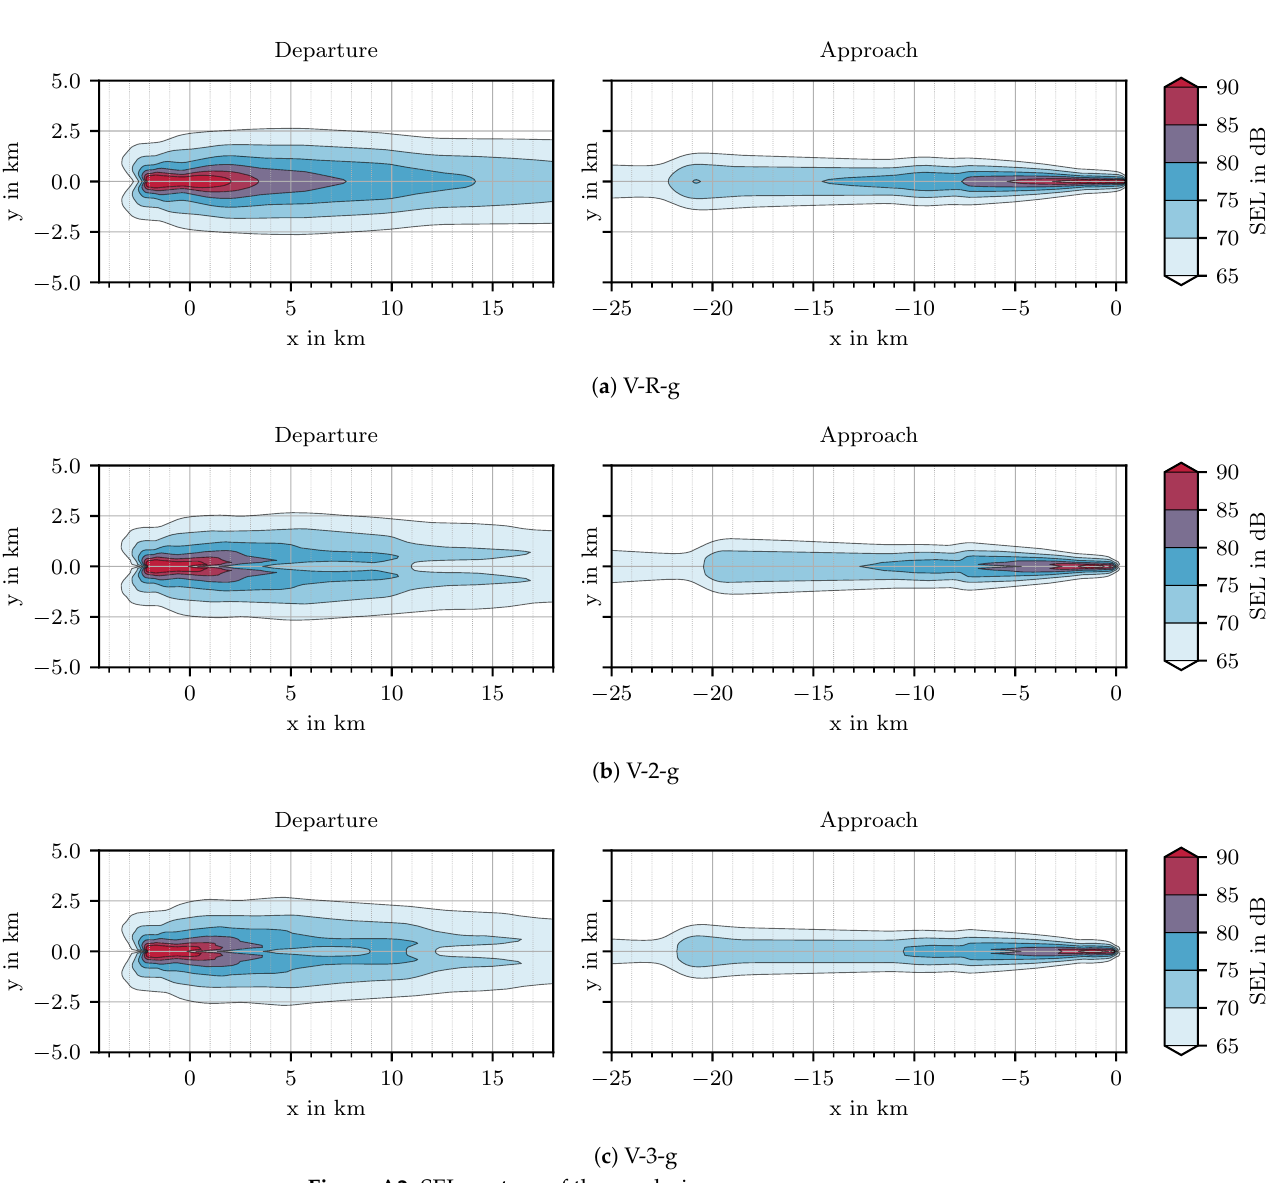
Figure A2. SEL contour of the neo